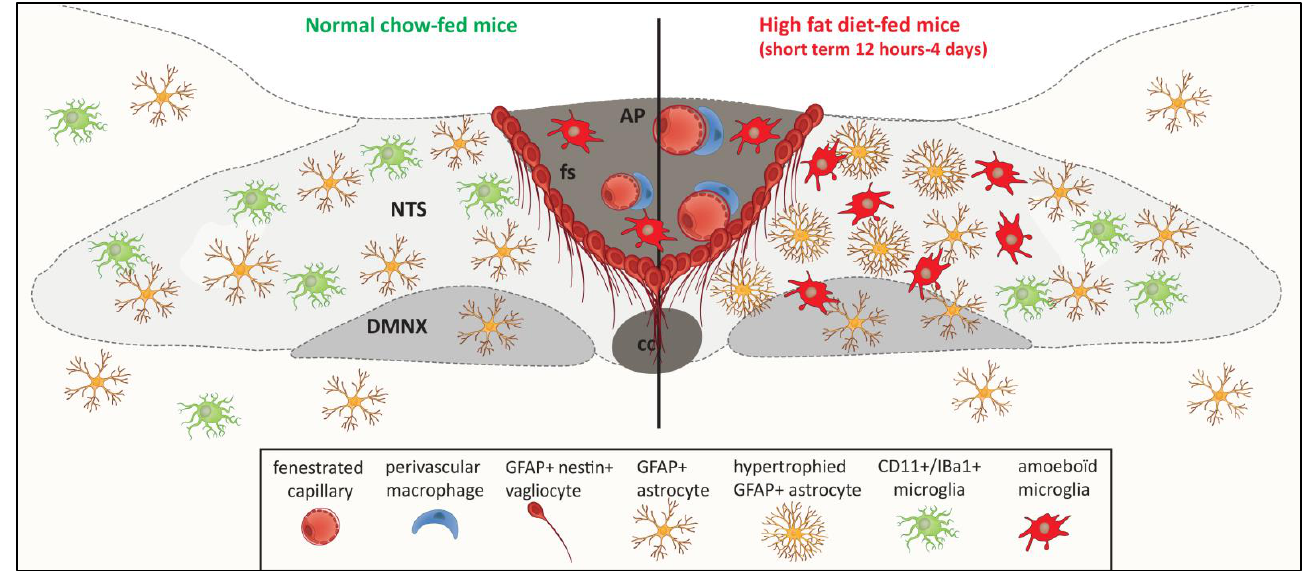
Figure 2. A cartoon illustrating the diversity of glial populations present in the DVC. GFAP+ astrocytes are particularly abundant in the NTS and DMNX when compared to other brainstem nuclei. By contrast, AP is virtually devoid of GFAP+ astrocytes. A population of GFAP+/nestin+ radiating cells, called vagliocytes, is present at the funiculus separens , the interface between AP and NTS. In addition, CD11+/Iba+ microglia are present throughout the rostro-caudal axis of the NTS and DMNX [31]. The AP contains a subpopulation of amoeboid CD86+ microglia [43]. An increase in the number and arborization of GFAP+ astrocytes, especially in NTS areas adjacent to AP, shortly after high-fat diet (HFD) consumption has been reported [30]. Moreover, an increase in the number of amoeboid microglia has also been observed in the NTS after HFD consumption (4 days; [44]). AP: area postrema, cc: central canal, DMNX: dorsal motor nucleus of the vagus nerve, fs: funiculus separens, NTS: nucleus of solitary tract, GFAP: glial fibrillary acidic protein, CD11: cluster of differentiation 11, Iba1: ionized calcium-binding adaptor molecule 1.